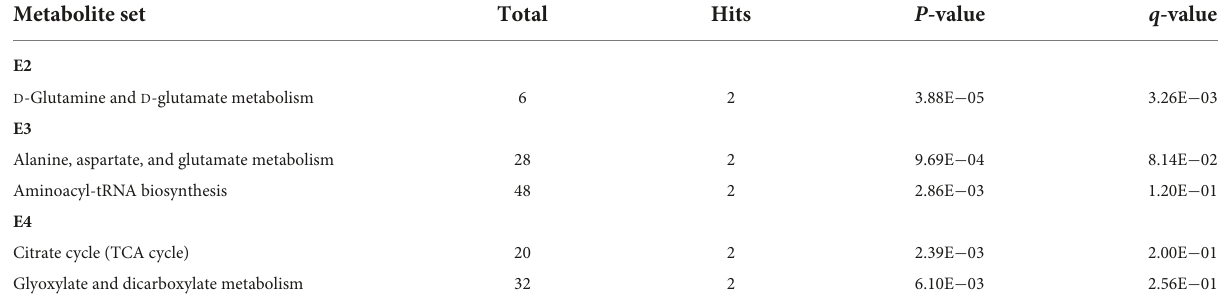
TABLE 4 Top pathways enriched by non-lipid metabolites in the E2, E3, and E4 groups. Metabolite